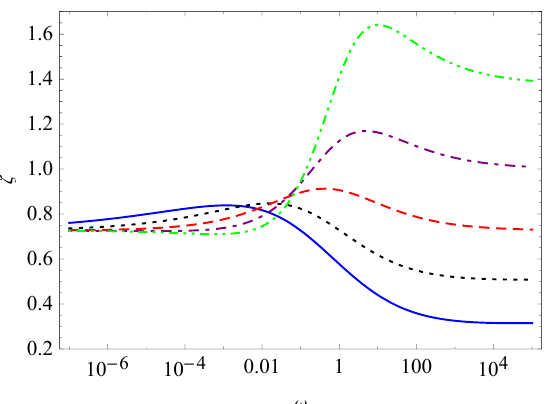
Figure 7. Curves of G s (solid line), G l (dotted line), and ζ (dashed line) versus ω for a = 1, b 1 = 1, b 2 = 2, α = 0.2, and β = 0.8 in the fractional five-parameter model (68).